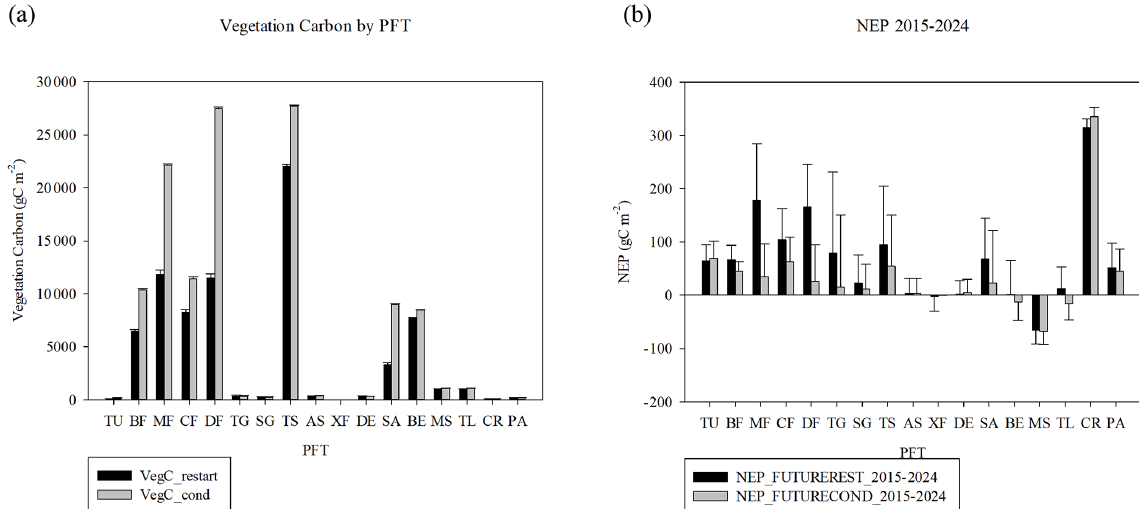
Figure 10. (a) Vegetation carbon by plant functional type in 2015 for the RESTART and for the CONDENSED experiments, (b) NEP by PFT averaged 2015–2024. PFTs are as follows: T is tundra, BF is boreal forest, MF is mixed temperate forest, CF is temperate coniferous forest, DF is temperate deciduous forest, TG is tall grasslands, SG is short grasslands, TS is tropical savanna, AS is arid shrublands, XF is xeric forests and woodlands, DE is deserts, SA is temperate savannas, BE is temperate broadleaved evergreen forests, MS is Mediterranean shrublands, TL is turf lawn, PA is pasture, and CR is crops. Error bars are 10-year interannual variability, computed as 95% confidence interval of year 2015–2024 for each PFT in each of the two